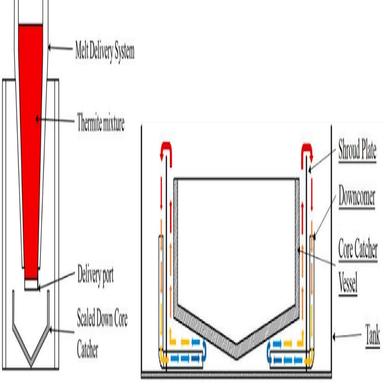
Schematic assembly of the test section (left) and schematic of the scaled down core catcher model (right).